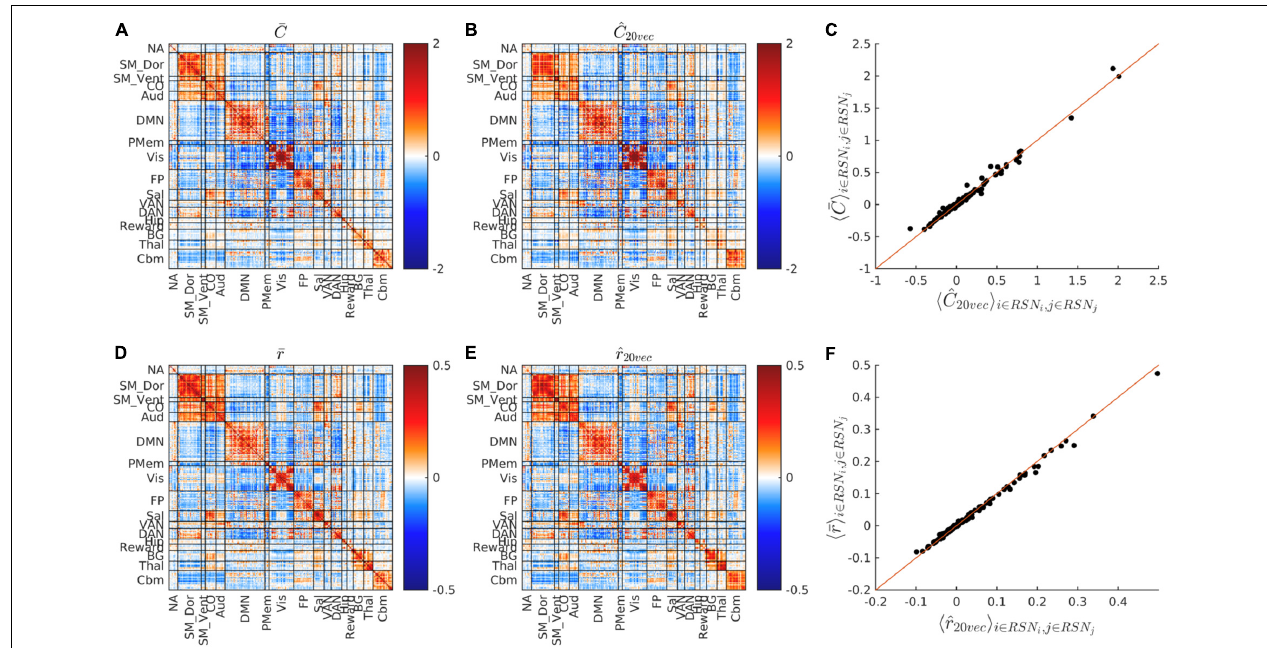
FIGURE 2 | FC matrix dimensionality reduction. (A,B) Show ¯ C and ˆ C , i.e., the cohort-average covariance FC matrix before and after dimensionality reduction. (C) Shows the scatter plot of ¯ C vs. ˆ C matrix block means, i.e., ¯ C k vs. ˆ C k (see section “Materials and Methods”). (D,E) Show the cohort-average, conventional Pearson correlation FC matrix before and after dimensionality reduction, i.e., ¯ r and ˆ r . (F) Shows the ¯ r k vs. ˆ r k scatter plot. Dimensionality reduction preserves almost all RSN structure of both covariance and correlation FC matrices. Note different scales in (D–F) vs. (A–C)